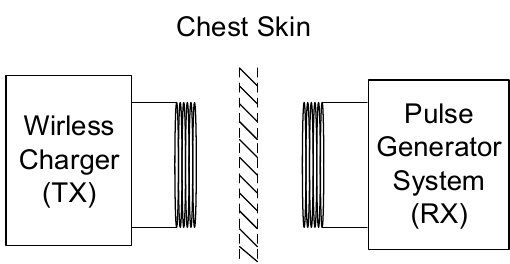
Figure 1. Generic power-combined data transfer system.